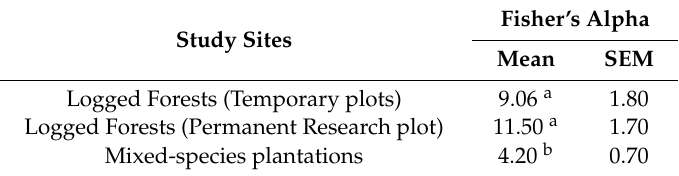
Table 6. Alpha diversity (Fisher’s alpha) of the three study